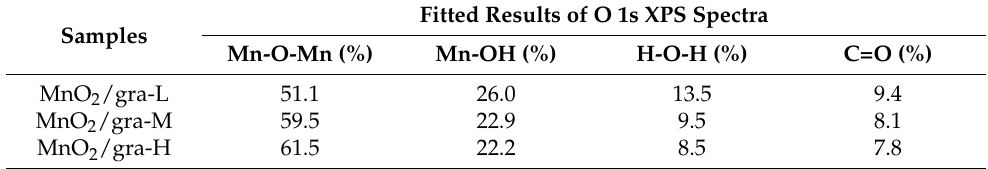
Table 2. Fitted results of O 1s XPS